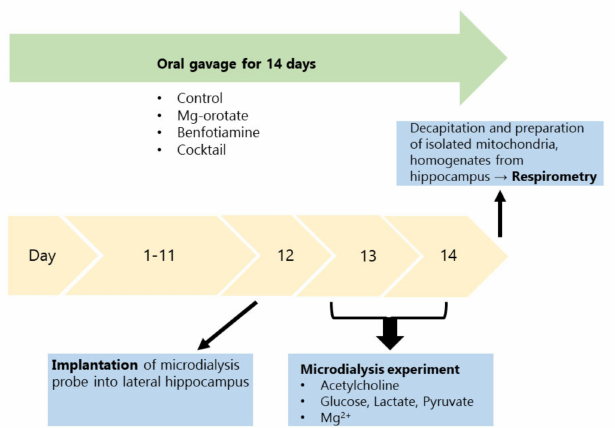
Figure 1. Flow chart of the experimental design. Rats received either nutrients or vehicle by oral gav- age for 14 days. The microdialysis probe was implanted on day 12. Microdialysis experiments (open field, scopolamine perfusion) were performed on day 13 and 14 to collect samples for acetylcholine, energy metabolites and magnesium measurements. Respirometry was done on day 14 with